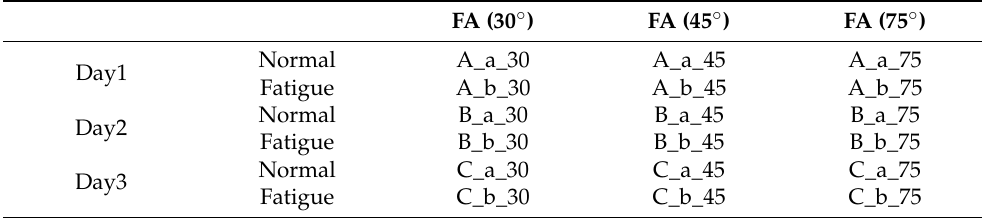
Table 2. sEMG signal datasets